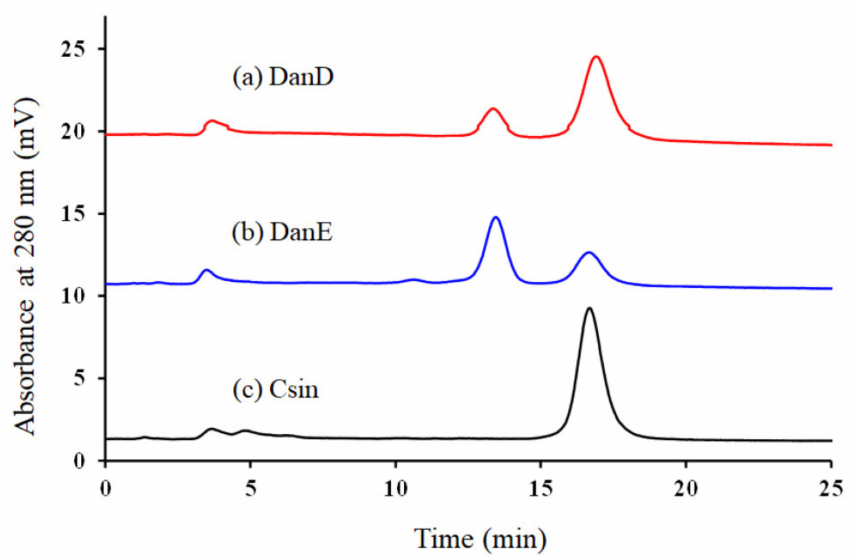
Figure 4. IEC profiles for the products after 2PAM treatment from the modification by using DanD ( a , red), DanE ( b , blue), and Csin ( c , black). The separation was performed on 3 connected HiTrap TM SP HP columns (7 mm I.D. × 25 mm) by using 50 mM sodium acetate buffer (pH 5.0) with a linear gradient of NaCl (0–0.5 M over 20 min). IEC analyses of the products obtained from DanD and DanE were performed 4 and 9 times,